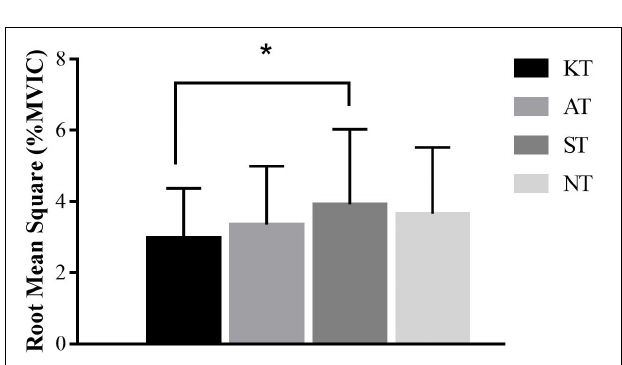
FIGURE 3 | Comparison of root mean square values (%MVIC) in forward-small translation during motor control test for peroneal longus. * means significant difference during different taping